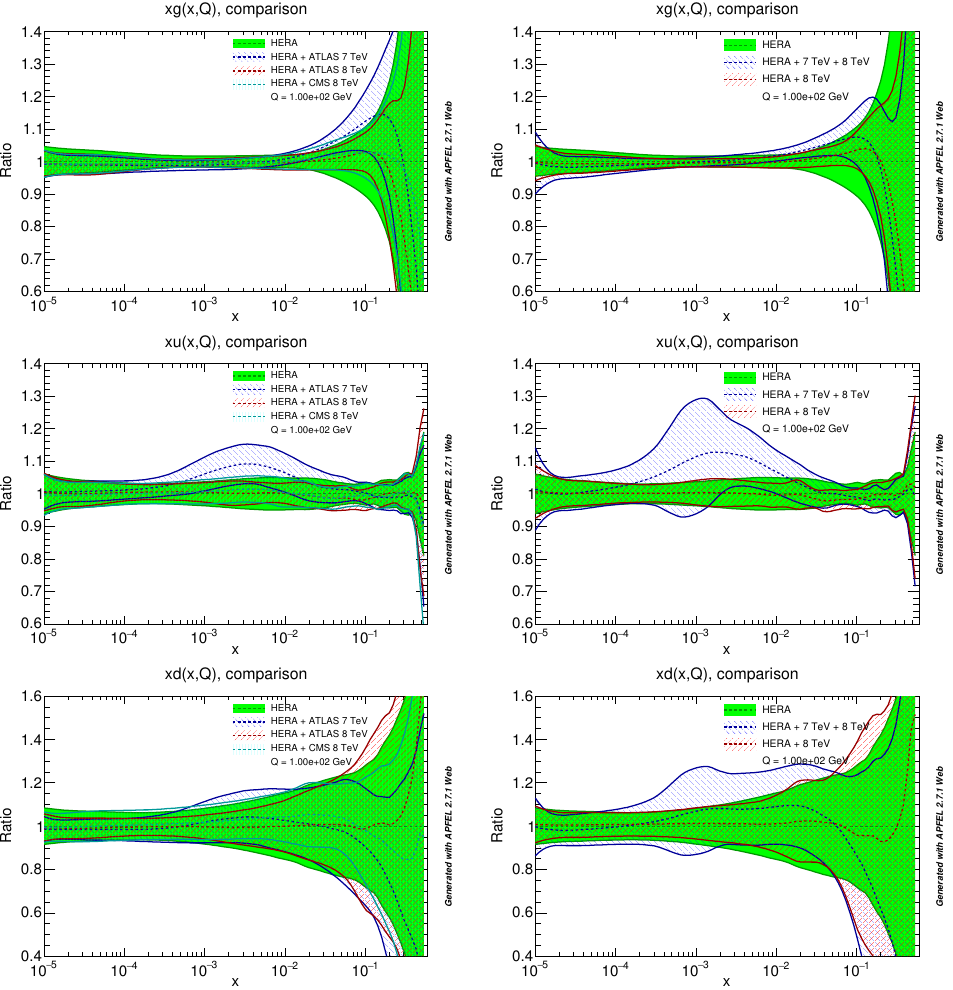
Figure 11 . Impact of the inclusion of 7 TeV p Z (middle row) and down (bottom row) in a HERA-only